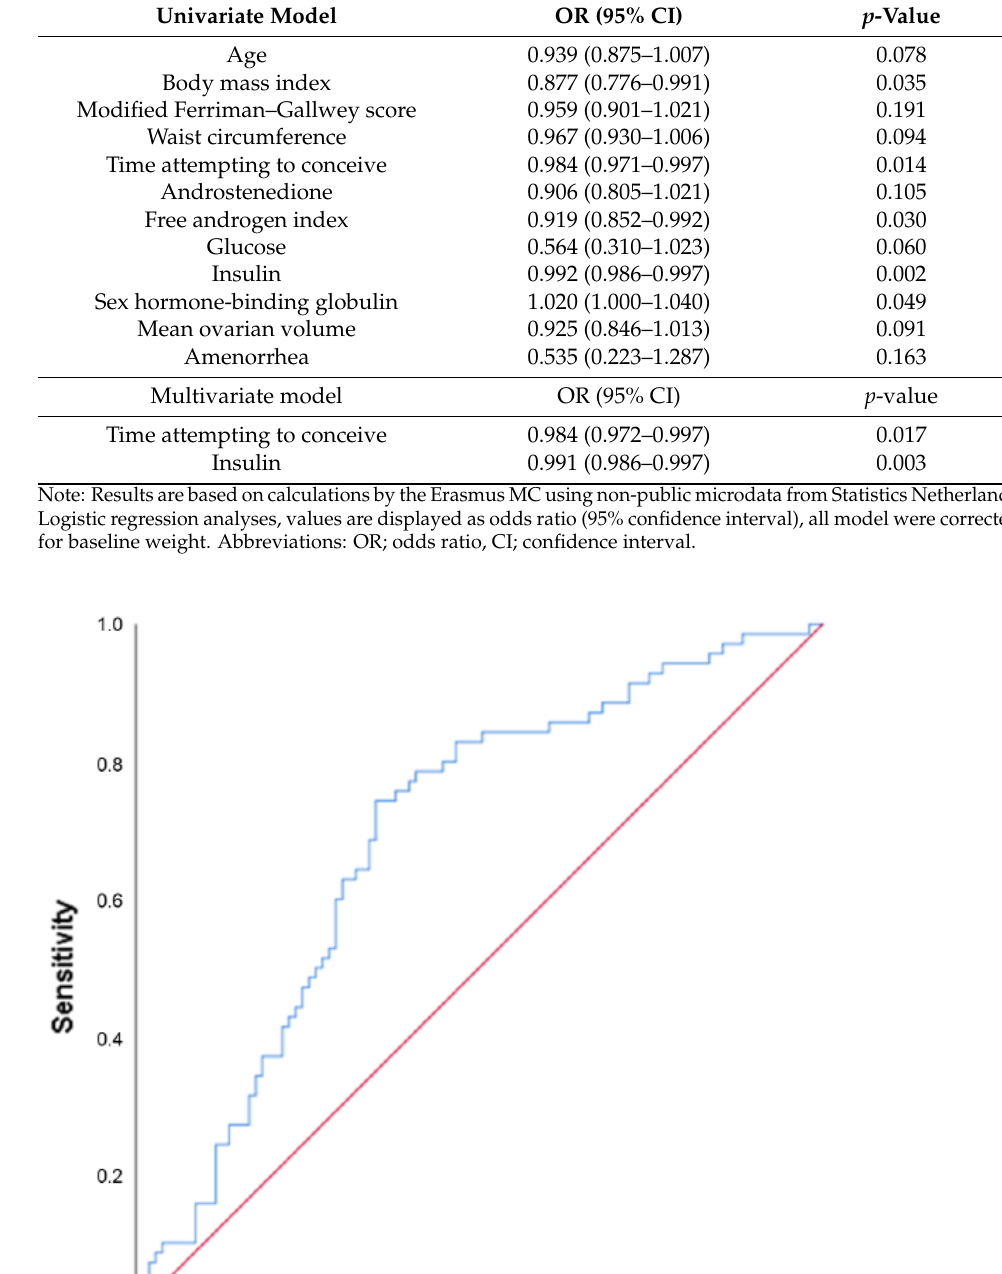
Table 3. Determinants of conception within 24 months after the start of the intervention.